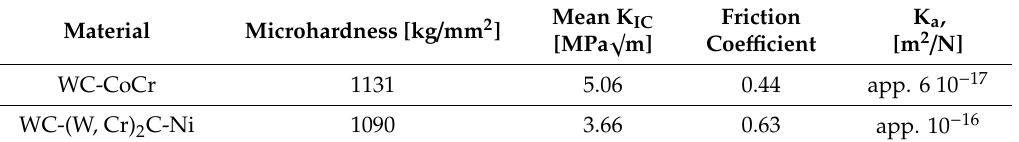
Table 5. Microstructural and mechanical properties of the HVOF coatings investigated by Bolelli et al.